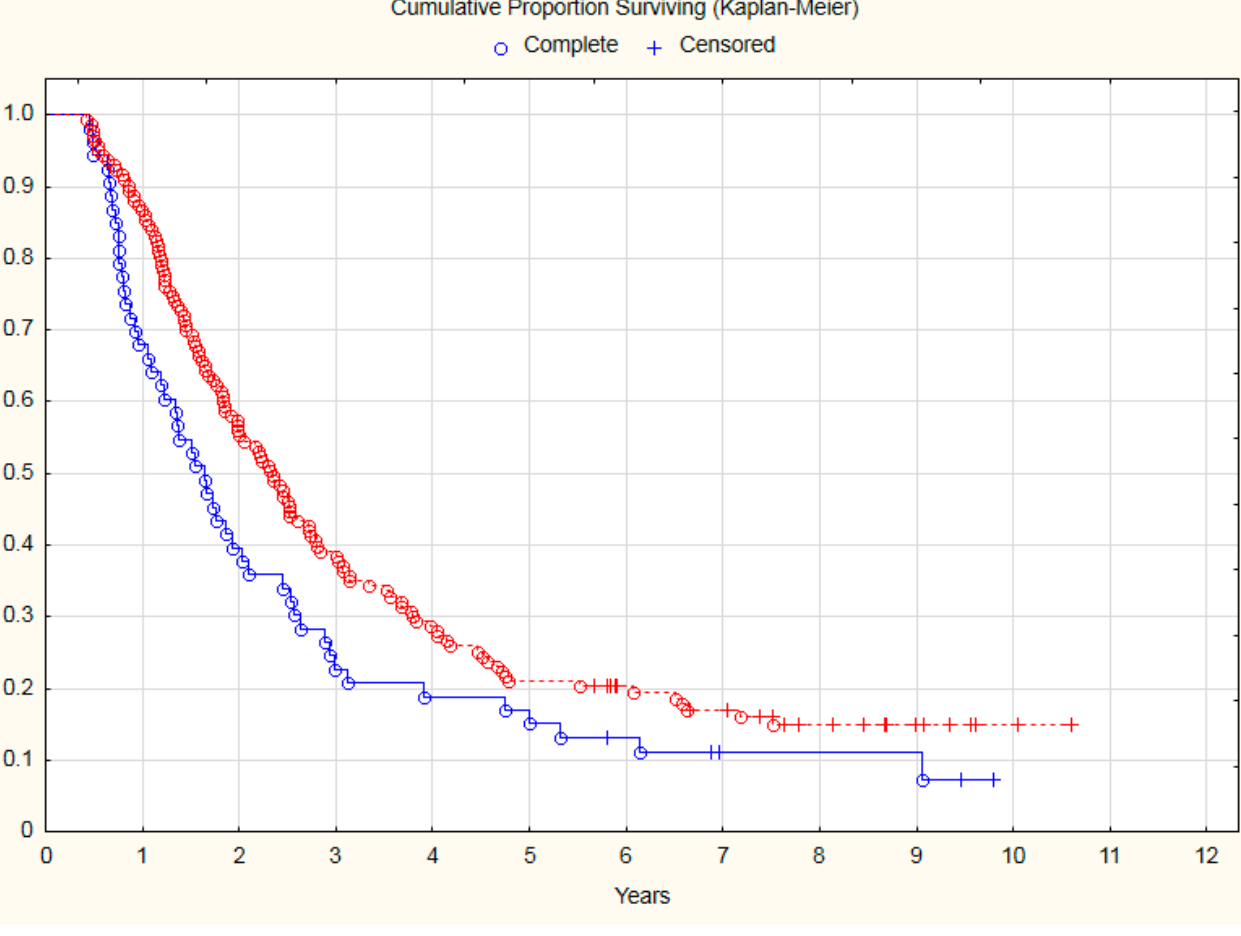
Figure 2. The comparison of PFS between NSCLC patients with KPS deterioration during chemora- diotherapy (blue line) and patients with stable performance status (red line). Median of PFS: 10.27 months vs. 13.33 months. Risk of NSCLC progression: HR = 1.44; 95% CI: 1.03–1.99; p = 0.03. The advancement of NSCLC expressed by the clinical stage, T4, or N3 feature was not significant for the deterioration of performance status (Table 2). Patients over 65 years of age had a significantly reduced risk of KPS deterioration (OR = 0.4; 95% CI: 0.17–0.92; p